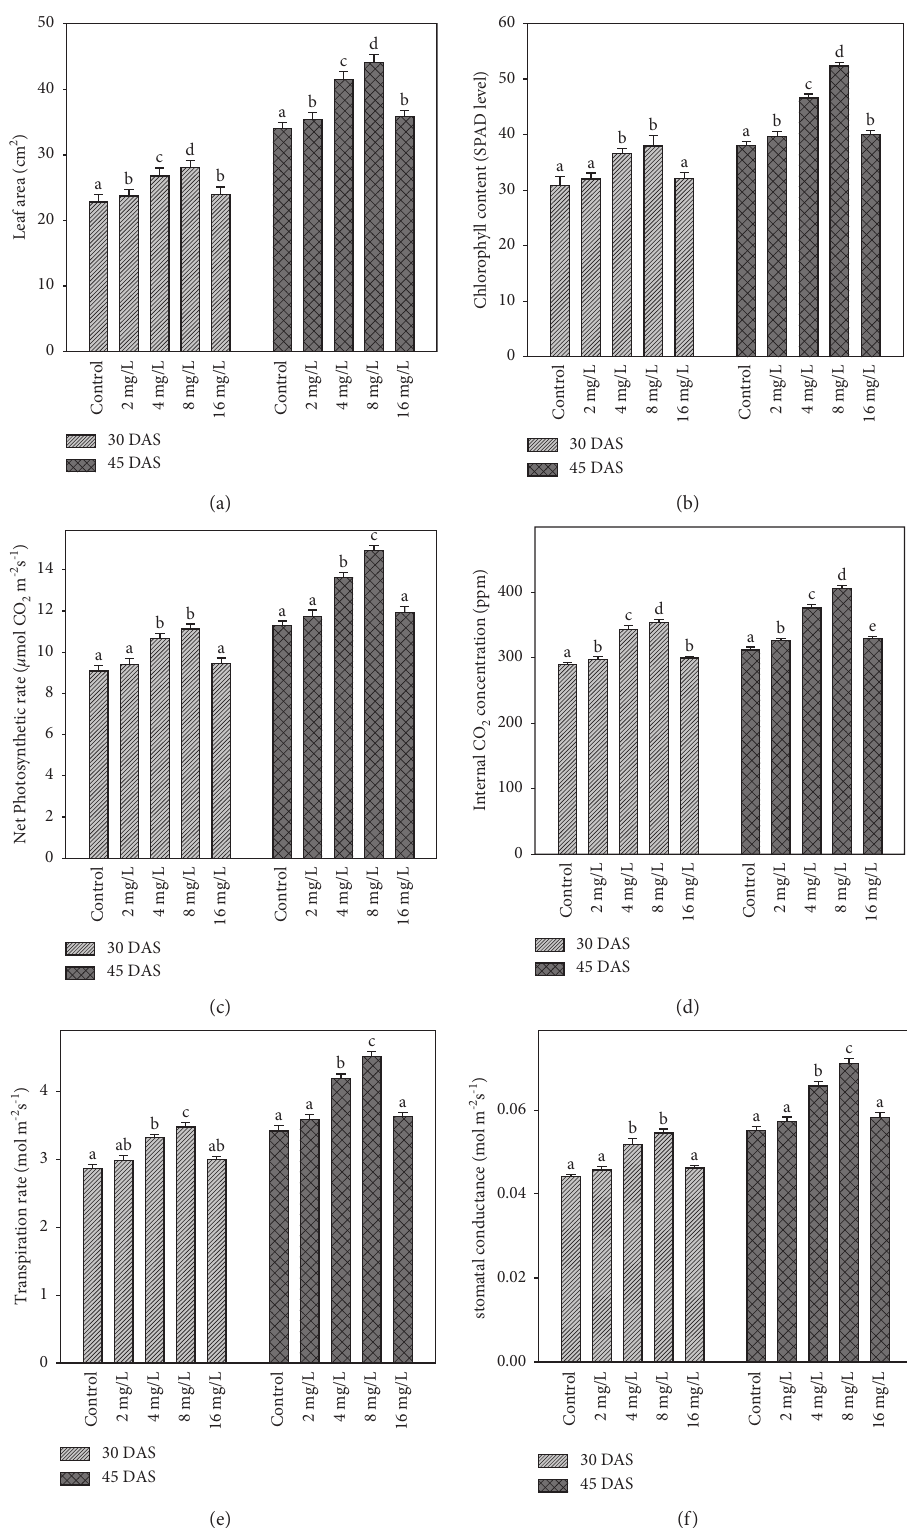
Figure 2: Effect of nanoparticles (NPs) on the (a) leaf area, (b) chlorophyll content, (c) net photosynthetic rate, (d) internal CO concentration, (e) transpiration rate, and (f) stomatal conductance of mustard at 30 and 45 DAS. All the data are the mean of five replicates ( n � 5), and vertical bars shows standard errors ( ± SE). (Different alphabet represents the significant difference ( p < 0 . 05) of treatments compared to the control